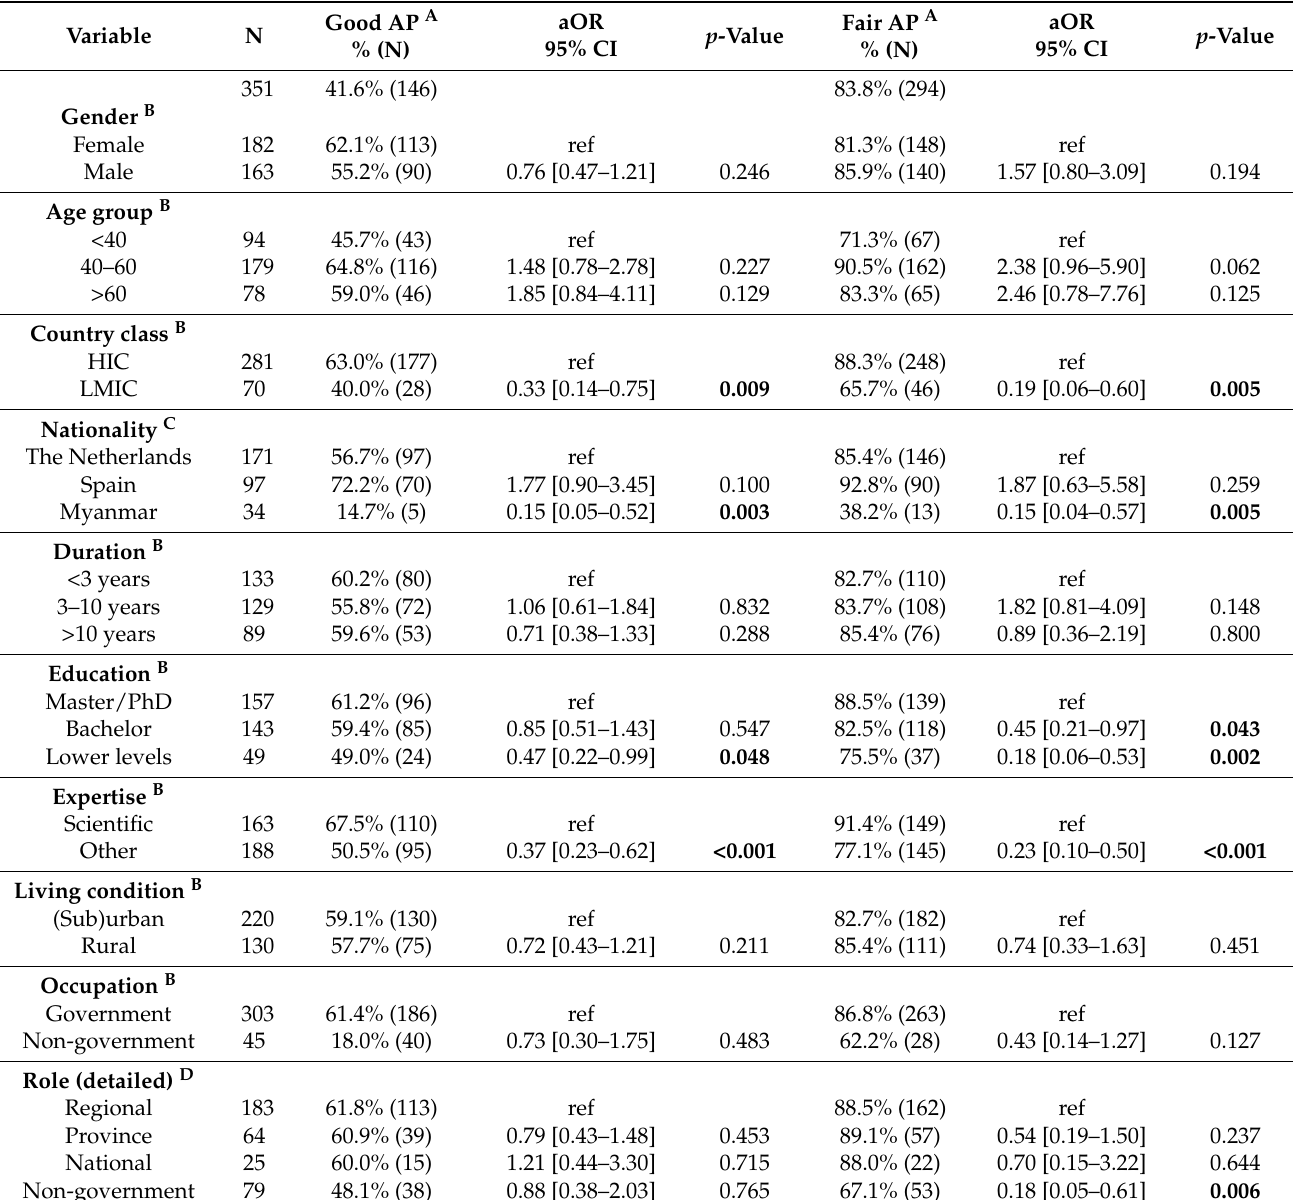
Table 4. Multivariate logistic regression (adjusted odds ratio, aOR) of good as well as fair personal attitudes and perception (AP) and demographic